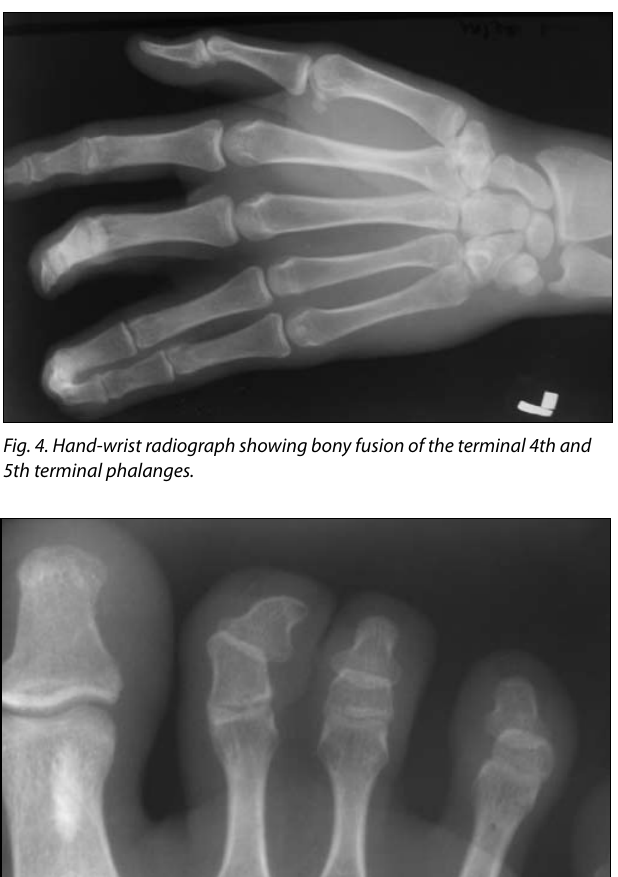
tissue syndactyly of the 4th and 5th fingers, with fusion of the terminal phalanges. Alignment deformity of the distal interphalangeal joints of the 2nd and 3rd fingers was also observed (Fig. 4).